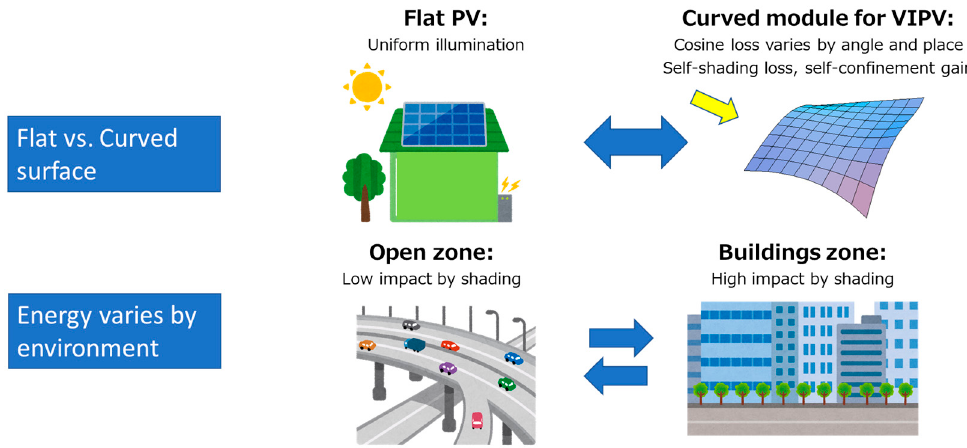
Figure 3. Main di ff erences between VIPV and typical solar panels in fi xed-tilt